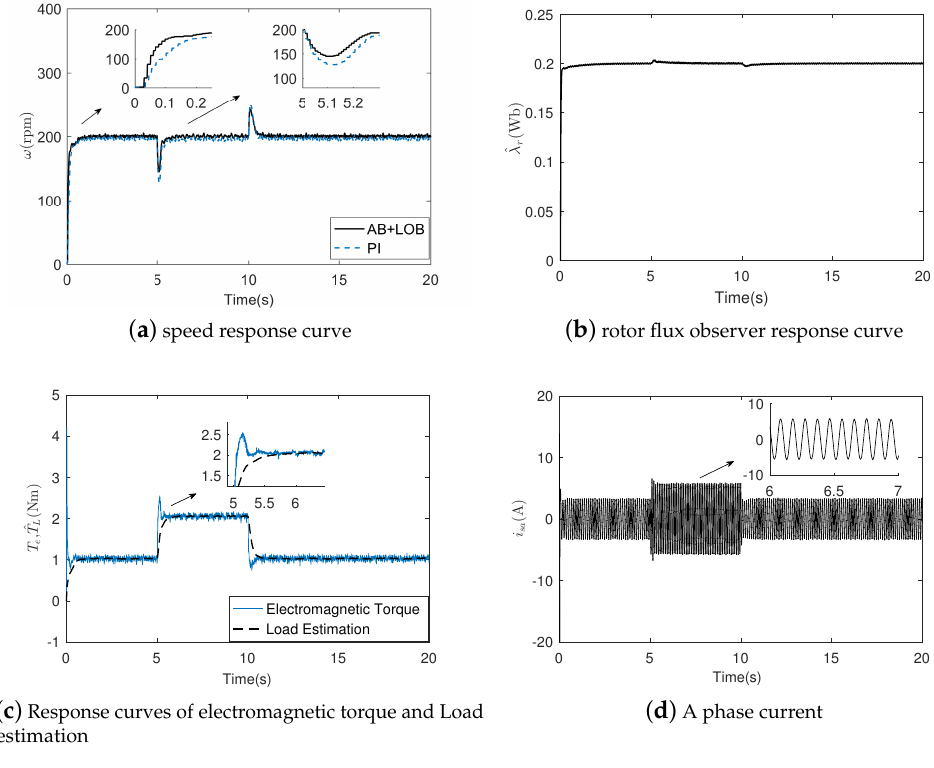
Figure 6. Response curves at 200 rpm.